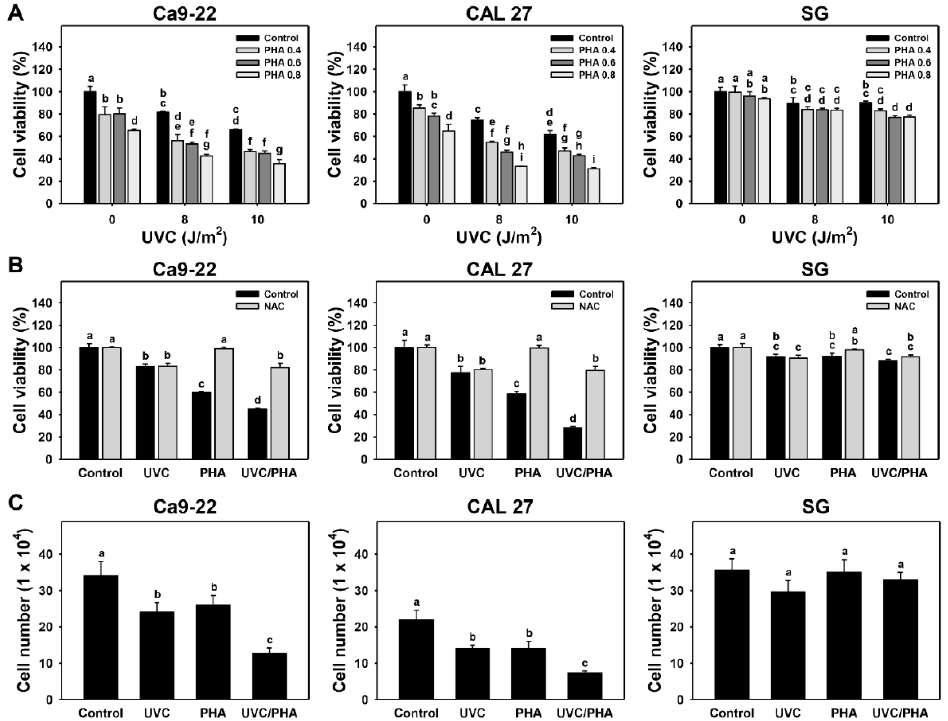
Figure 1. UVC/PHA selectively killed oral cancer cells but not normal oral cells. In the presence or absence of NAC, oral cancer (Ca9-22 and CAL 27) and normal (SG) cells were grouped into four treatments, i.e., control, UVC, PHA, and UVC/PHA, for 24 h. ( A ) ATP assay for different doses of UVC and/or PHA. ( B ) ATP assay for UVC and/or PHA treatments at 8 J/m 2 and 0.8 μ M, respectively. ( C ) Trypan blue exclusion assay. For comparison, treatments labeled with different letters (a to i) produced significantly different results ( p < 0.05). Data are presented as mean ± SD ( n = 3 independent experiments, with each experiment performed in three replications).